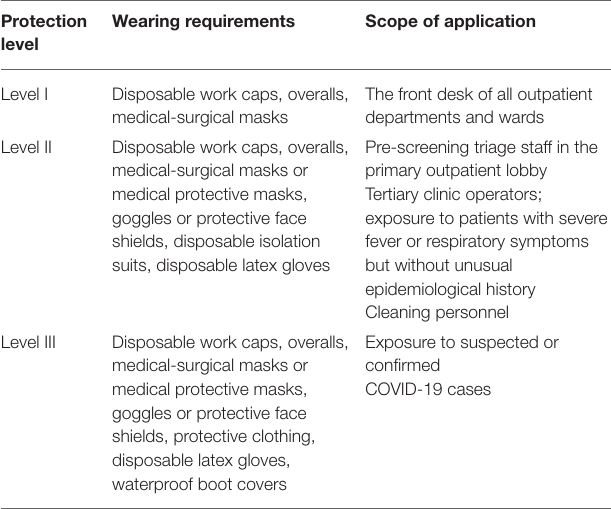
TABLE 1 | Requirements and scope of application of three levels of wearable